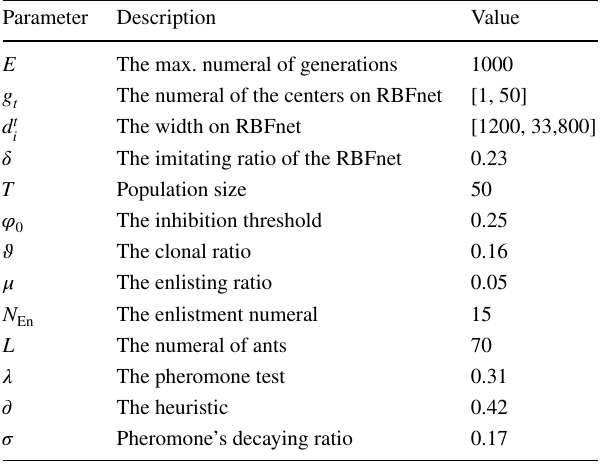
Table 5 Parametric set for the HIAO algorithm in the crude oil spot price prediction instance